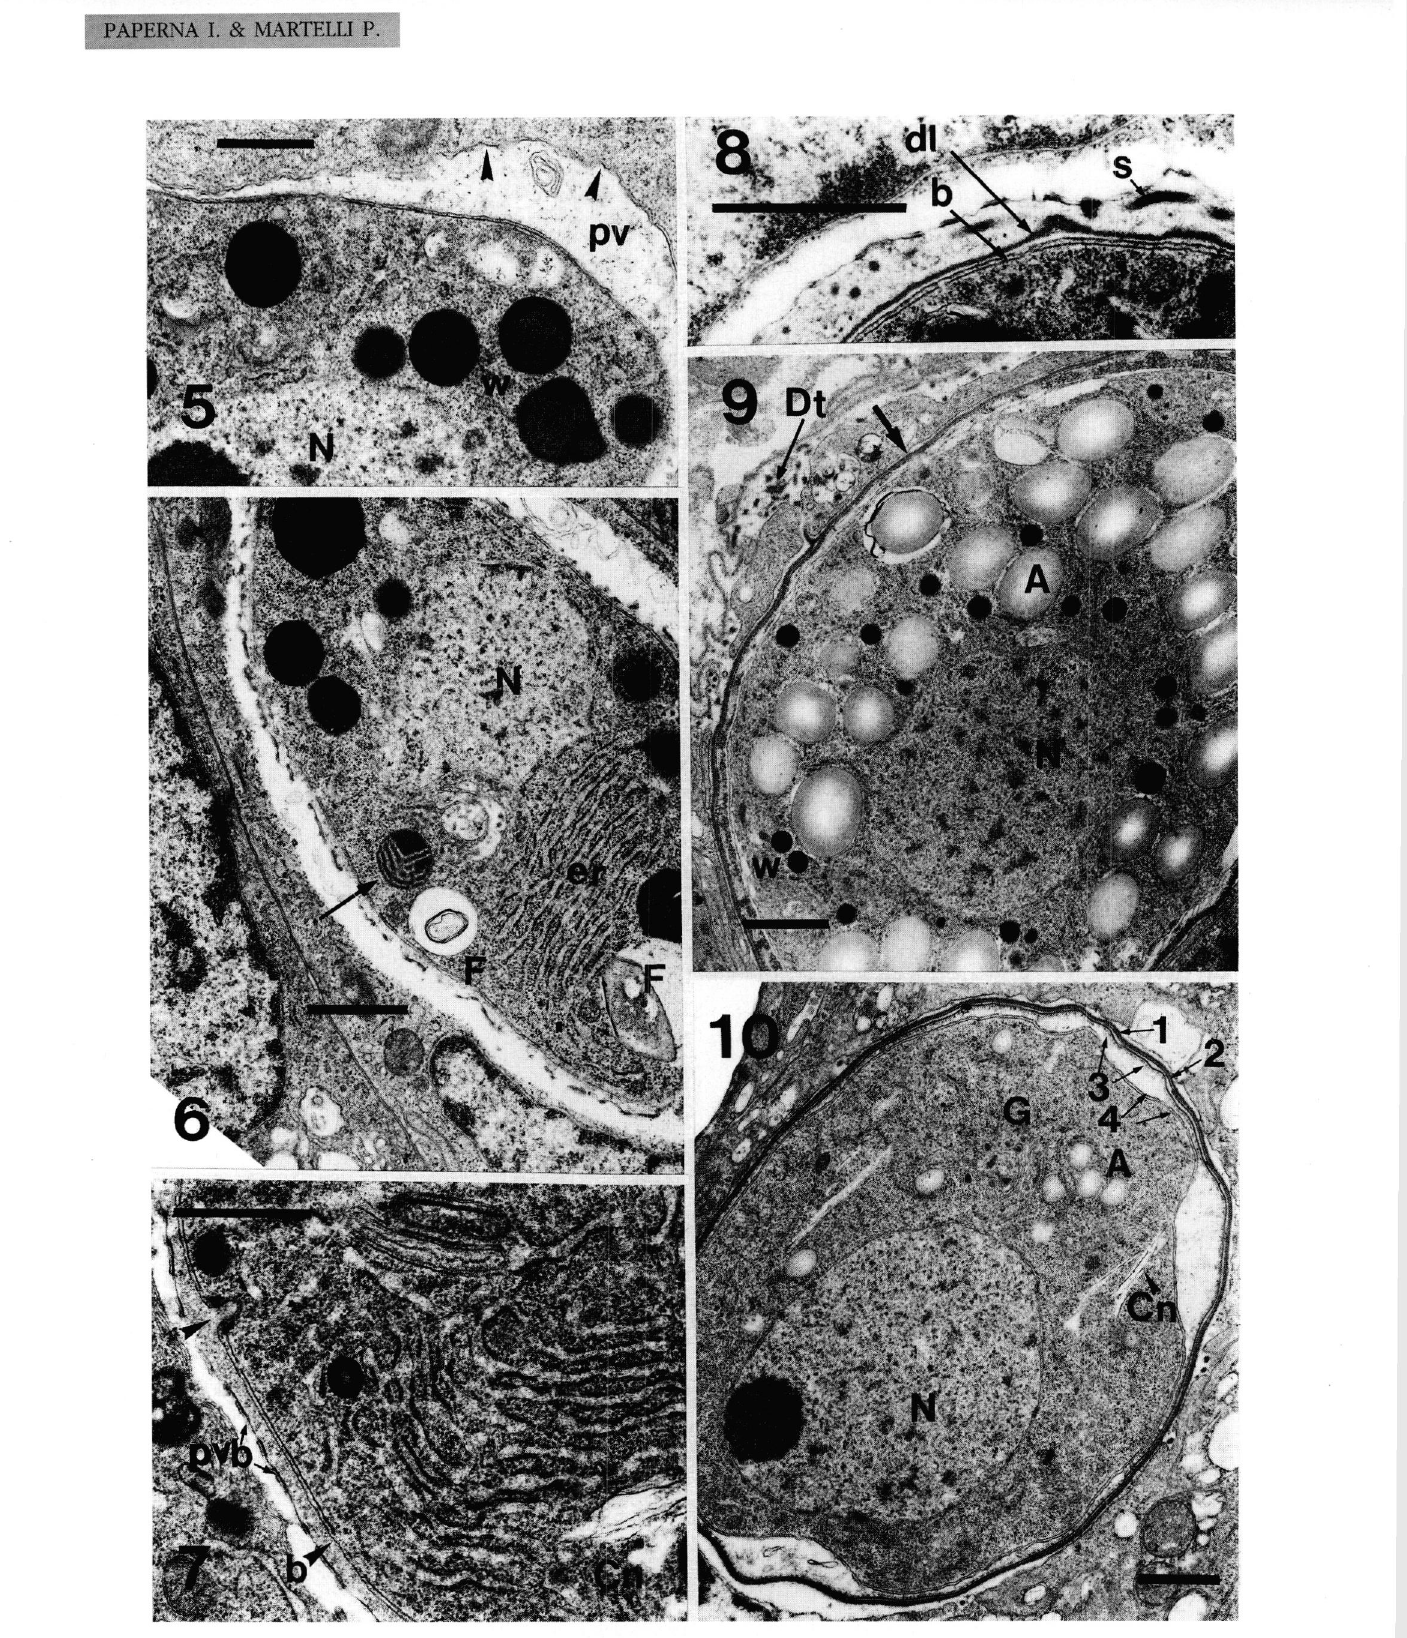
Figs. 5-10. - Mature macrogamonts and zygotes of S. singaporensis. 5. Macrogamont with developed wall-forming-like bodies in PV lined with fine bilayered wall (arrows). 6. Mature macrogamonts with ER array; note laminated wall-forming-like body (arrow). 7. Enlarged view of the macrogamont ER array; also showing details of the PV border, and the granular matrix, the macrogamont's border and the micropyle (arrow). 8. View of the zygote wall's electron-dense coat, the PV granular matrix and the electron-dense strands. 9. Zygote, arrow: the forming wall and the electron dense coat. 10. Zygote already enclosed by four membranes.